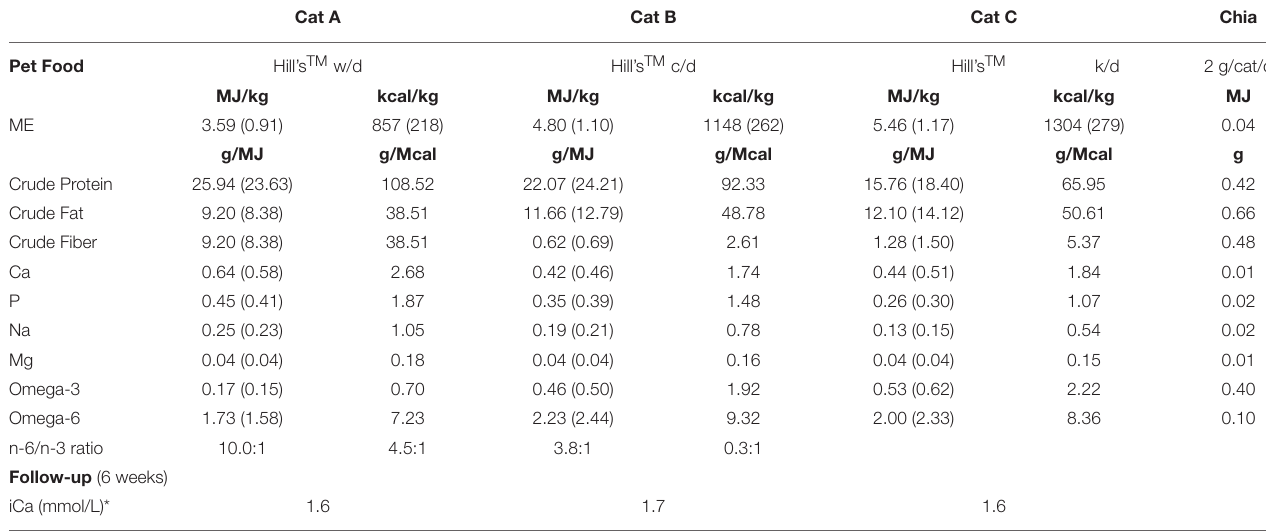
TABLE 3 | Prescribed high-moisture pet foods’ characteristics with data between parentheses indicating the amount of nutrient according to daily food